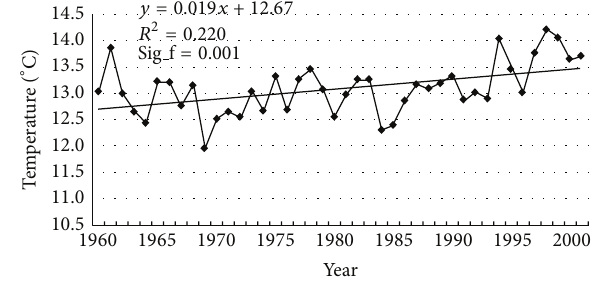
Figure 2: Average annual temperature trends in the Lower Yellow River Region from 1960 to